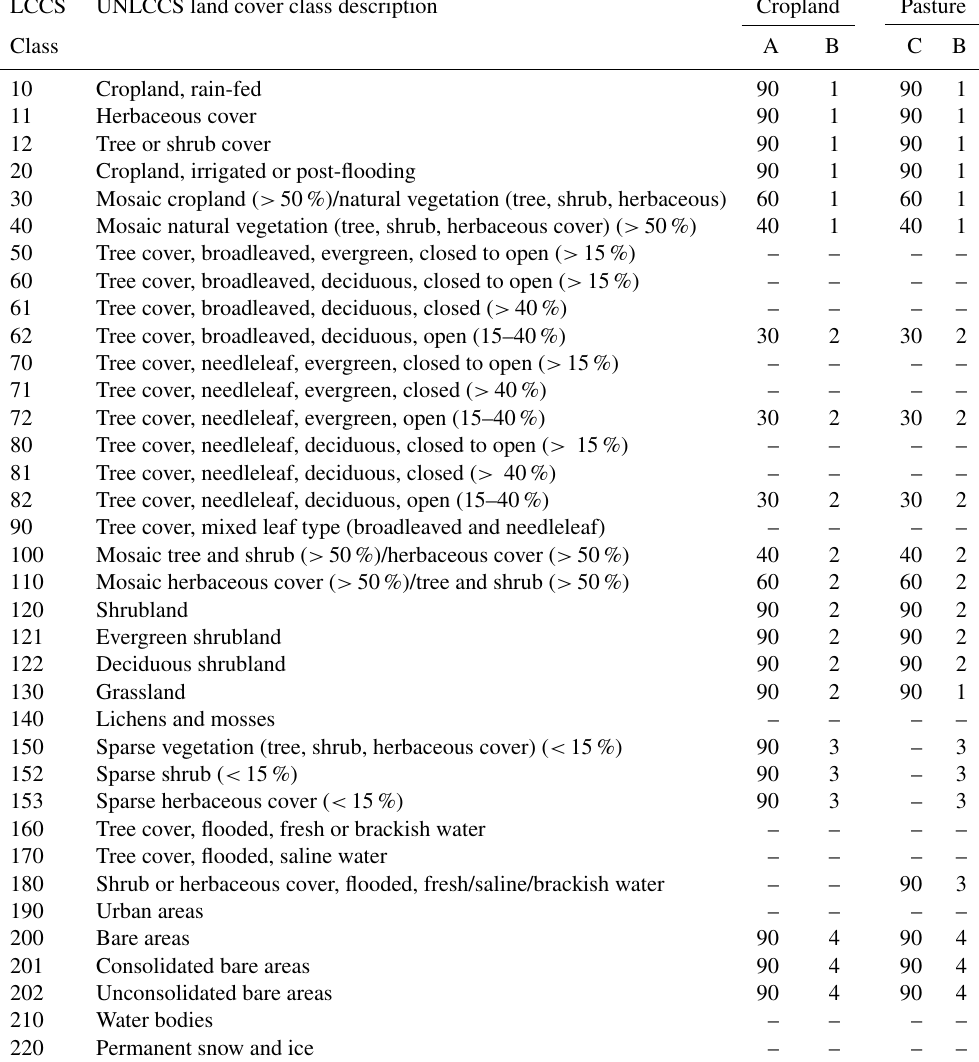
Table 1. Percentages of cropland and grazing land allocated in four steps from the original ESA CCI land cover classes (between 0 and